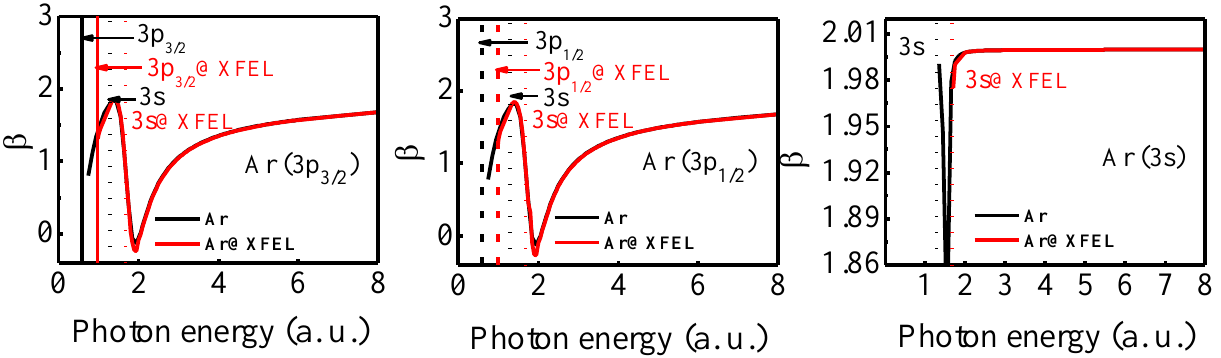
Figure 8. Angular distribution asymmetry parameter (β) of p 3/2 (Left), 3p 1/2 (Middle), and 3s (Right) subshells of Ar (black) and Ar@XFEL (red). Solid, dashed, and dotted vertical lines represent the threshold for 3p 3/2 , 3p 1/2 , and 3s thresholds of free (black) and confined atom (red), respectively.